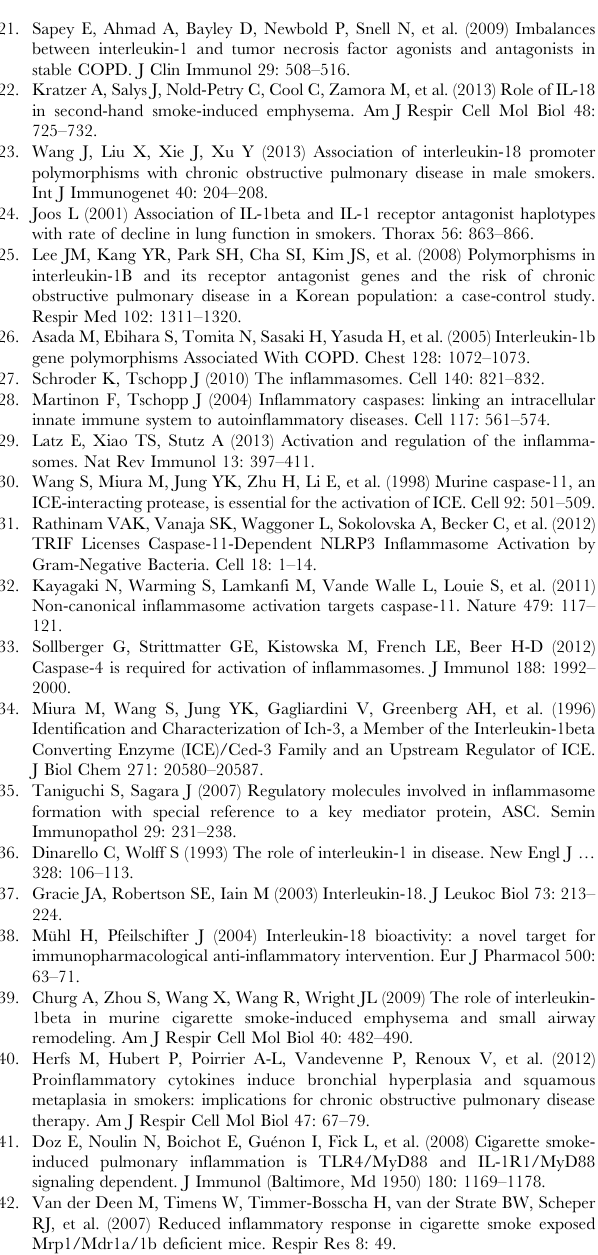
Figure S4 Role of the IL-1 a in CS-driven model. IL-1 a -/- mice were exposed to CS or room air (control) twice daily for 3 consecutive days alongside wild-type controls. BALF and lung tissue was collected 24 hours after the last exposure for measurement of ATP (A), caspase 1 activity (B), IL-1 a (C),